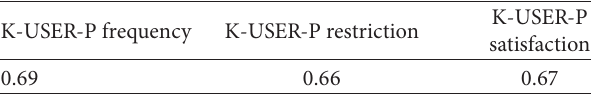
Table 2: Internal consistency of K-USER-P ( 𝑁 = 67